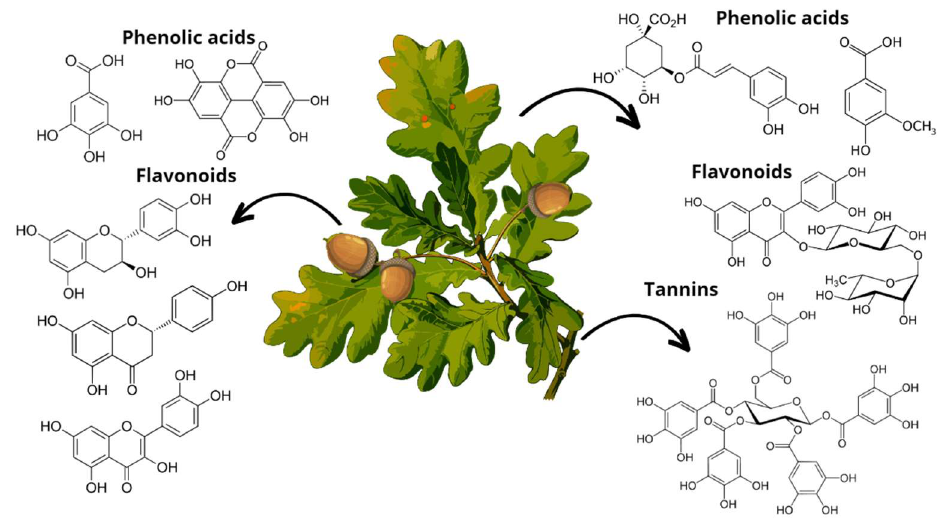
Figure 5. Main phenolic compounds found in Quercus leaves (chlorogenic acid, vanillic acid); acorns (gallic acid, ellagic acid, epicatechin, naringenin, quercetin), and bark